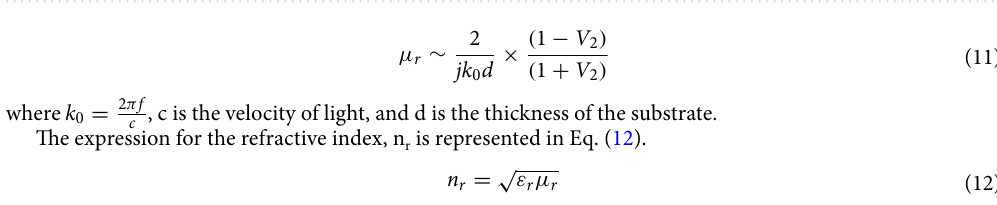
Figure 4. Surface current distribution of the unit cell ( a ) 2.38 GHz, ( b ) 4.24 GHz, ( c ) 5.98 GHz, ( d ) 9.55 GHz, ( e ) 12.1 GHz, and ( f ) 14.34